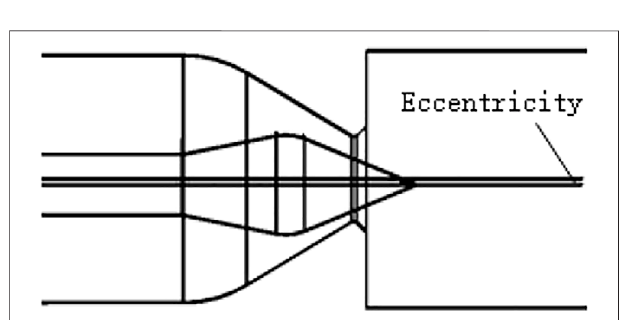
FIGURE 4 | Eccentric model of the injection